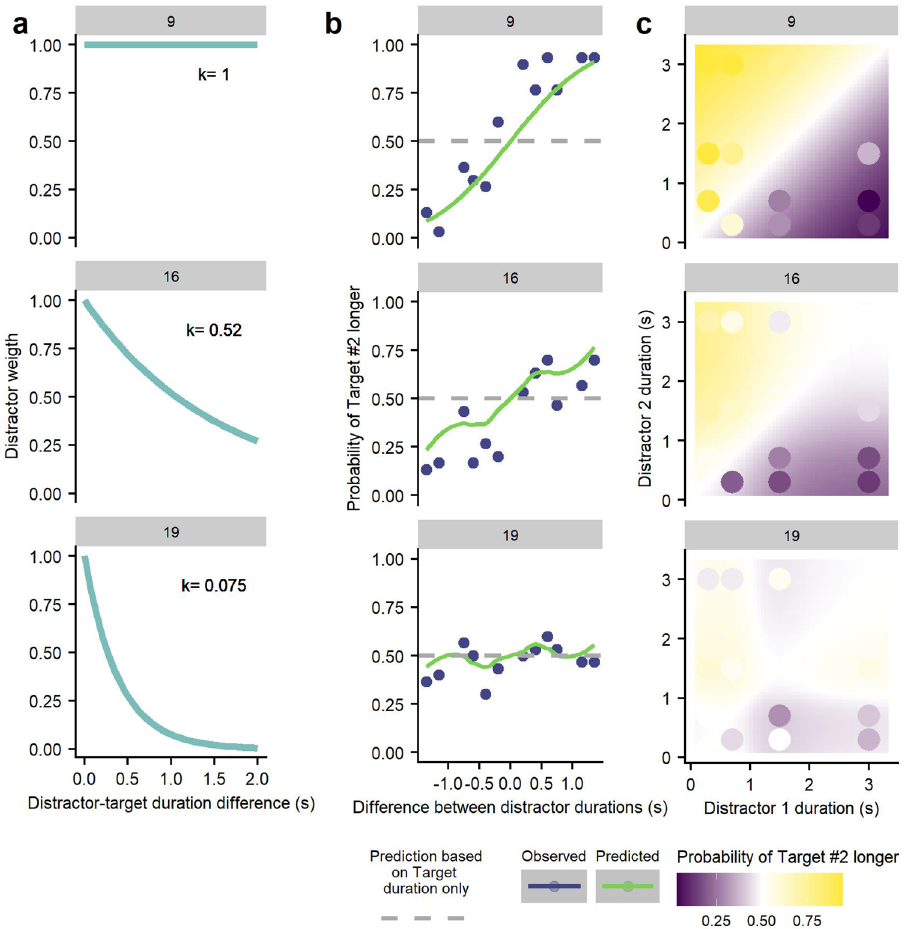
Figure 6. Sample of three participants (9, 16 and 19) with high, medium and low values of leaking factor. ( a ) The weight function of the leaking factor predicts how much weight the distractors will have depending on their similarity with the target. ( b ) Fit between predicted and observed response probabilities as a function of the difference between distractors. ( c ) Comparison between observed (coloured circles) and predicted (background colour) probabilities of response for any combination of